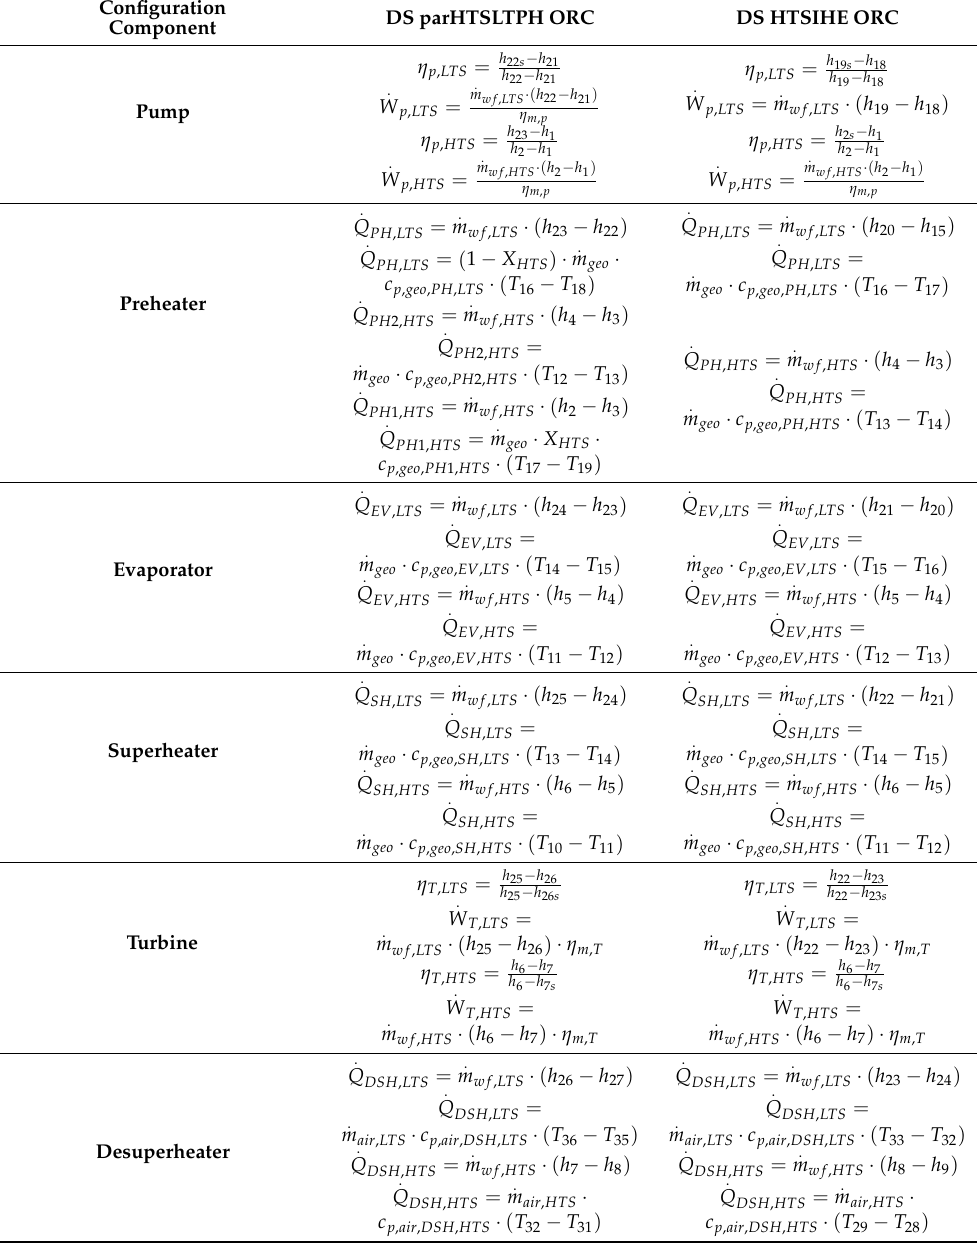
Table A2. The relations for each component (first law analysis) for the DS parHTSLTPH ORC and DS HTSIHE ORC